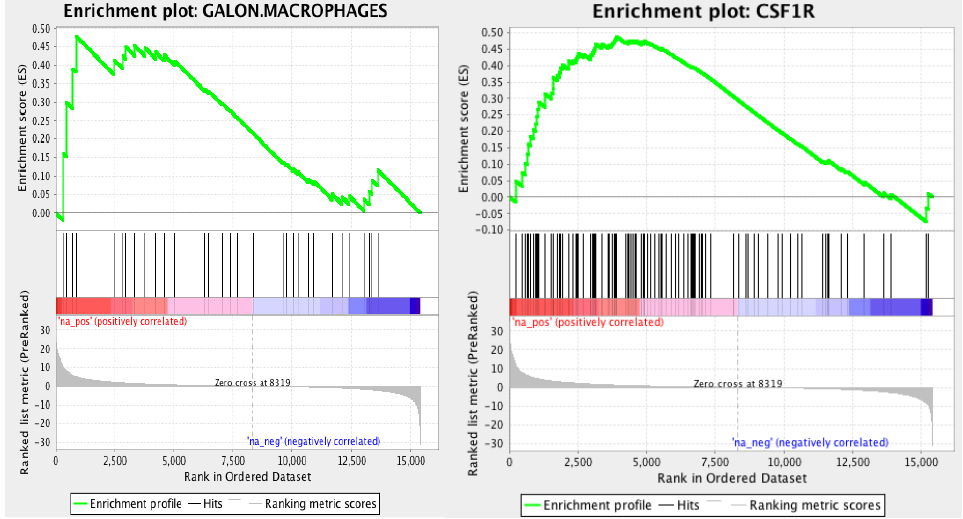
Figure 2. TGCA gene expression pathway analysis, high enrichment of TAM, and overexpression of colony-stimulating factor 1 receptor (CSF-1R).